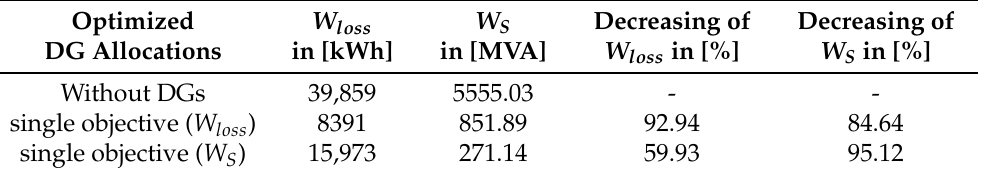
Table 7. Results for optimal solutions of Opt 2 optimization model for different objective functions (W2 workflow).